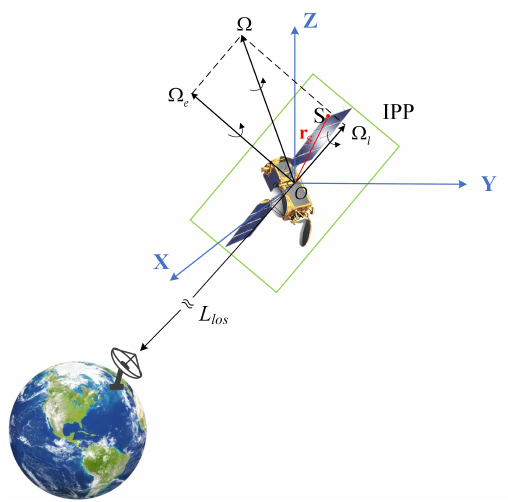
Figure 1. ISAR observation